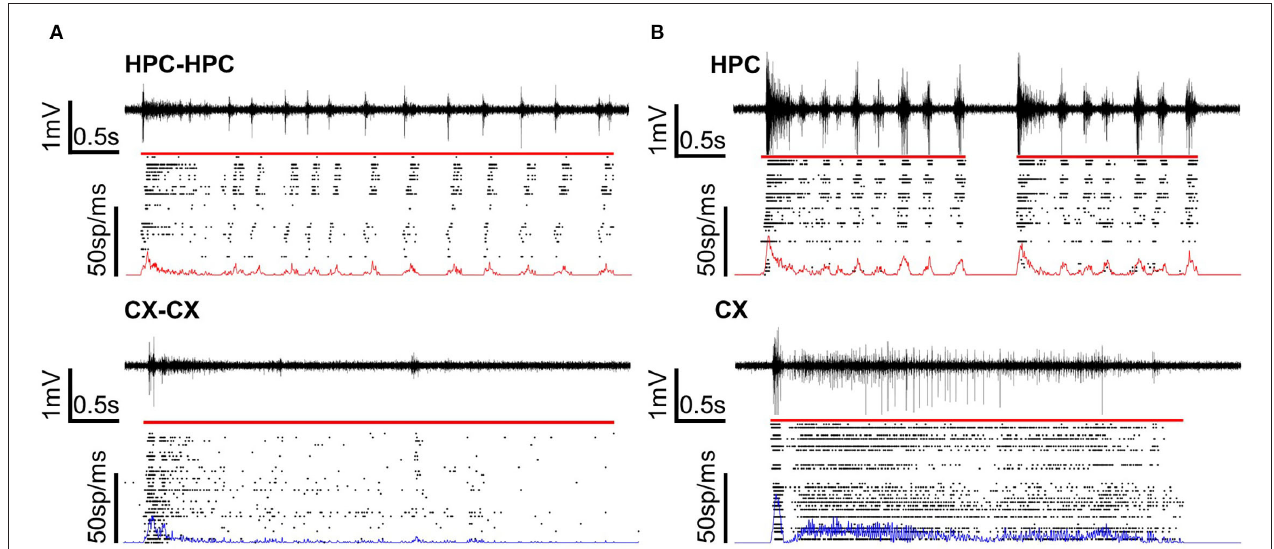
FIGURE 2 | Voltage and raster plots of homogeneous and heterogeneous coculture models. (A) Homogeneous cocultures of CX or HPC networks. (B) A heterogeneous coculture of CX and HPC networks. The voltage plot shows signals recorded from one representative electrode under the sample. The raster plot shows the detected spikes over the network. Line plots on the raster plots show the firing frequency over the cultured area. The firing rate of the HPC network is in red and the firing rate of the CX network is in blue. The red line over the raster plot shows the detected length of a typical burst or burst in each type of coculture model.